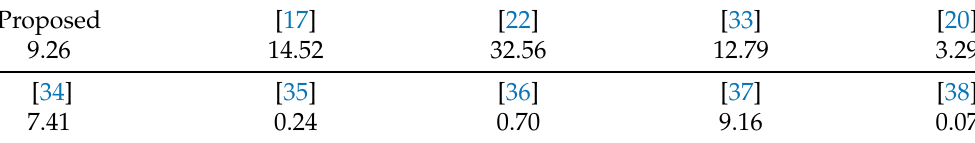
Table 2. Average runtime (in seconds) comparison of different methods on 20 IR-VIS test image pairs.